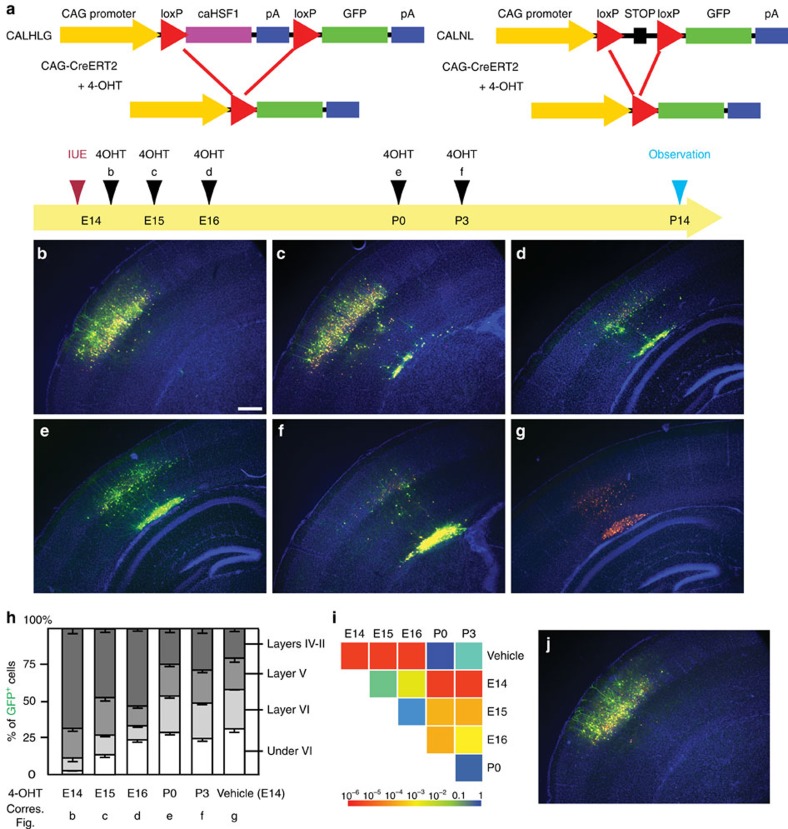
Heterotopias formed by temporal prenatal expression of caHSF1 persist after birth.(a) Scheme describing the experiments. CAG-promoter-loxP-FLAGcaHSF1-loxp-GFP (CALHLG) with CAG-RFP and CAG-CreERT2 was electroporated at E14. 4-OHT was administered at the indicated time points, and all samples were fixed at P14. 4-OHT administration at any time point consistently resulted in excision of the FLAGcaHSF1 unit (indicated by GFP expression) in over 95% of RFP+ electroporated cells. FLAG immunohistochemistry confirmed complete sequestration of FLAG-tagged caHSF1 by 2 days after 4-OHT injection. (b–i) Distribution of the electroporated cells was observed at P14 after administration of 4-OHT or vehicle only (control) at different time points (b–g), and quantitatively analysed (h,i). Scale bar, 0.5 mm. Panel i shows pairwise comparisons of cumulative radial distributions using Kolmogorov–Smirnov (K–S) test. Each P value is shown in a color according to the scale at the bottom. Without 4-OHT (vehicle only), CALHLG expression causes heterotopia formation (g,h), similar to pCAG-caHSF1 introduction. Delay of caHSF1 until after birth (4-OHT injection at P0 or P3) causes the formation of large heterotopias (e,f,h) (i: P=NS, K–S test). Expression of caHSF1 at low levels for a very short period (4-OHT injection 6 h after IUE at E14), did not form heterotopias (b,h) (P=NS compared with pCALNL-GFP, n=6). Expression of caHSF1 until E15 or E16 was sufficient for heterotopia formation (c,d,h) (P<0.05 compared with the vehicle control or pCALNL-GFP (see j), n=13, 5, respectively). Data are represented as mean±s.e.m. (j) No migration defects by electroporation of pCALNL-GFP with CAG-CreERT2 and pCAG-RFP followed by 4-OHT injection at E16 (see a).